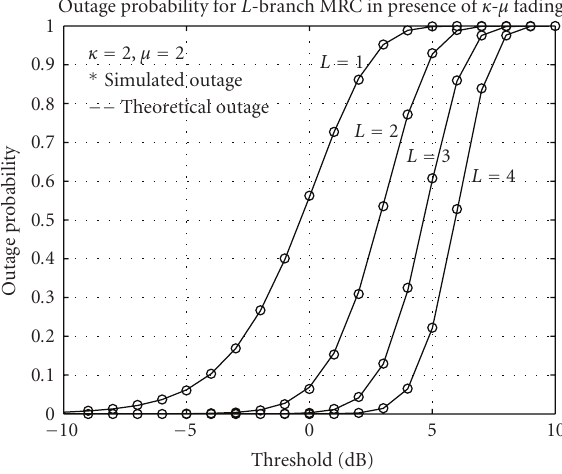
Figure 6: Outage probability for κ = 2 and μ = 2.